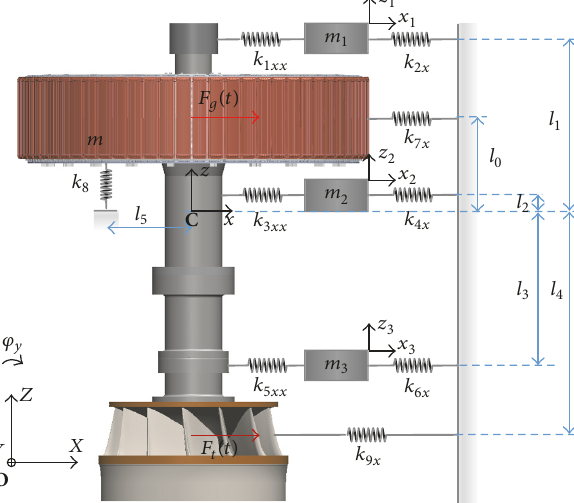
Figure 5: Simplified 10 DOF model to simulate LHG dynamic